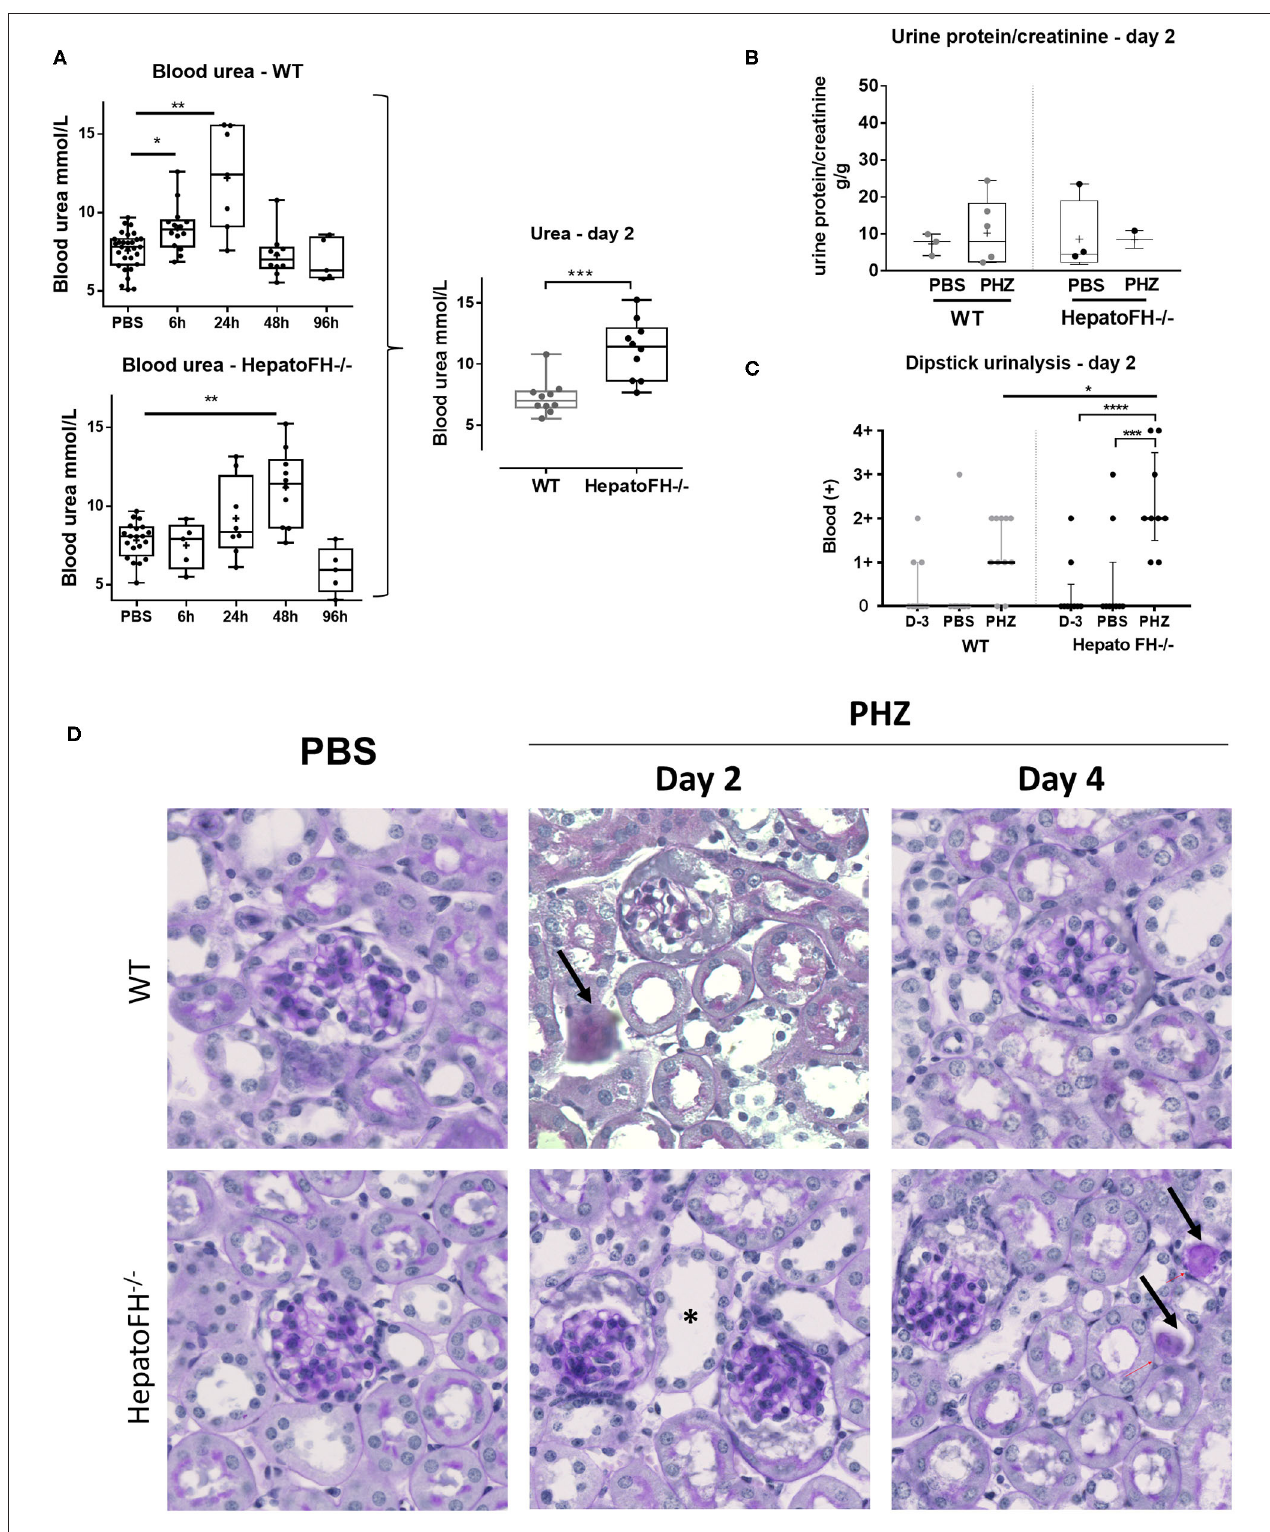
FIGURE 1 | Hemolysis induces clinicopathologic changes in HepatoFH − / − kidneys (A–C) . Evaluation of renal function by measurement of plasmatic urea level (A) , urine protein-creatinine ratio (B) and presence of blood in urine by urinary dipstick (C) in WT and hepatoFH − / − mice, at 6, 24, 48, and 96h after PBS or PHZ